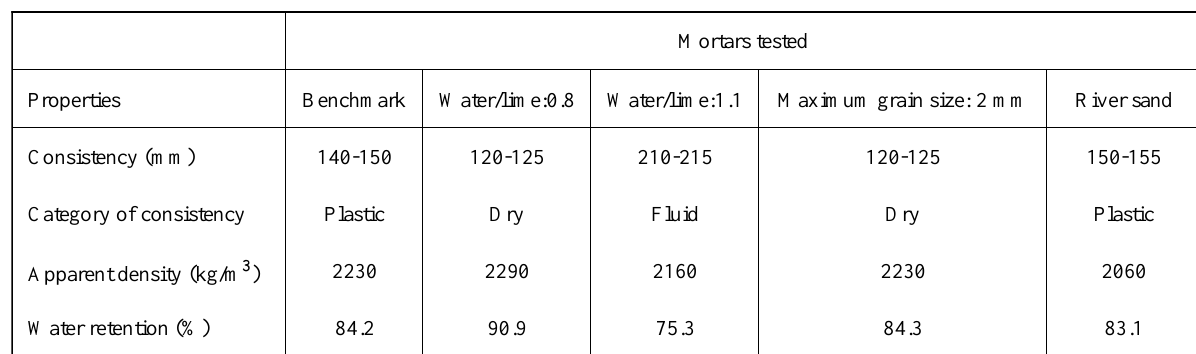
Table 2. Properties of air lime mortars in a fresh